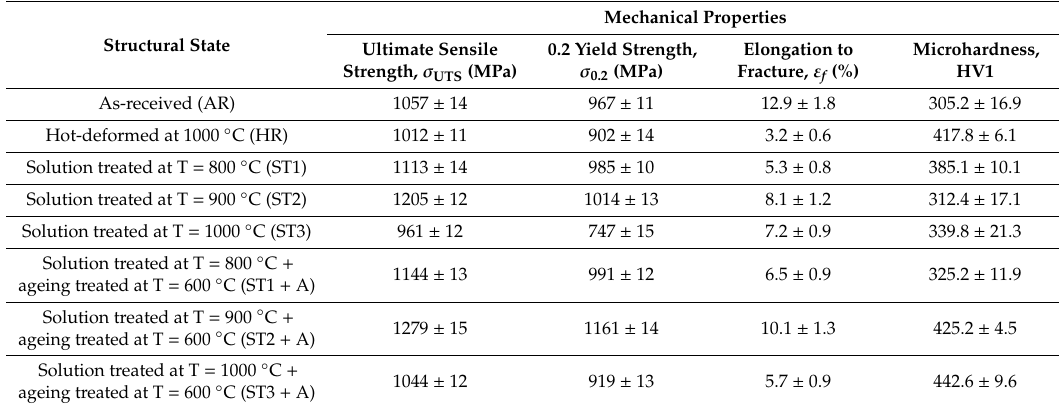
Table 2. Mechanical properties of TM processed Ti-6246